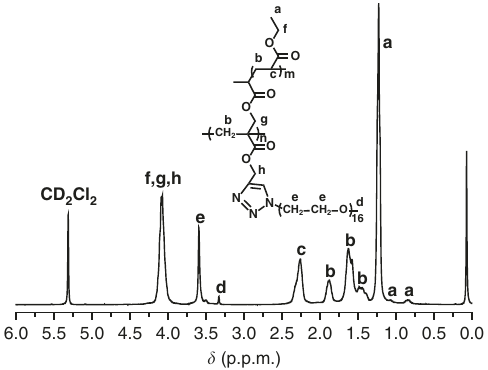
Fig. 6 Chemical structure of asymmetric molecular double-brush. 1 H NMR spectrum of PA- g -PEA/PEO 5 asymmetric molecular double-brush in CD 2 Cl